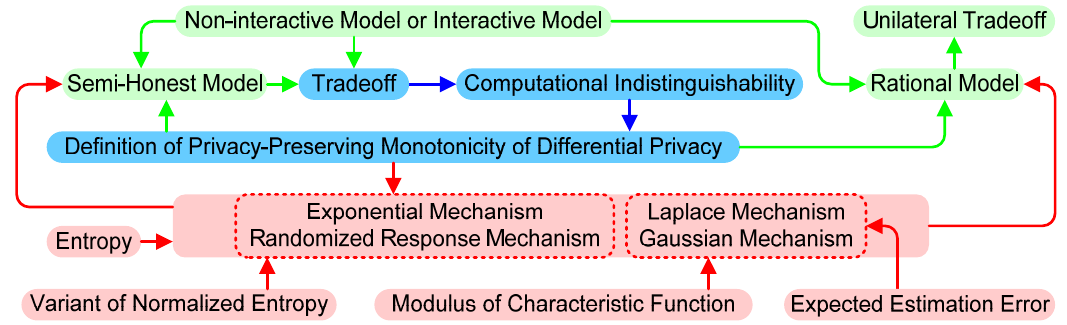
Figure 1. Research framework of this